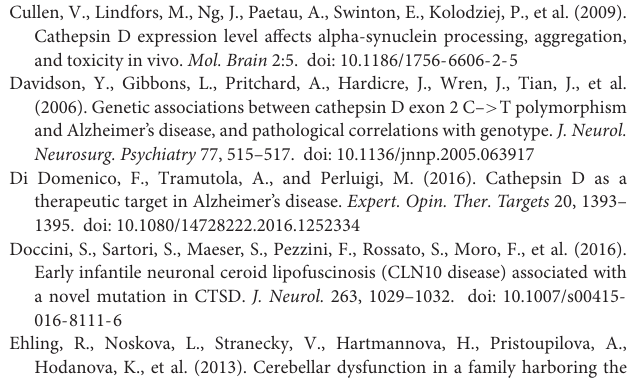
Supplementary Figure 4 | Cellular localization of PD-associated CTSD variants in SH-SY5Y CTSD KO cells. Representative confocal microscopy images of immunofluorescence stainings of PD-CTSD variants, overexpressed in SH-SY5Y cells deficient for CTSD (CTSD KO). Cells were stained for CTSD (green), the lysosomal marker LAMP2 (red), and DAPI as nuclear stain (blue). Yellow staining indicates lysosomal localization of CTSD variant. Scale bar: 20 µ m. Supplementary Figure 5 | Analyses of confocal images for CTSD localization, lysosomal vesicle number, and size as well as maturation of PD-associated CTSD variants. (A) Analysis of intracellular co-localization of PD-associated CTSD variants in SH-SY5Y cells deficient for CTSD (CTSD KO). The Pearson’s correlation coefficient was used to determine the co-localization of PD-CTSD mutants with lysosomal marker LAMP2 (total n = 11–15 in three independent experiments). (B) Quantification of LAMP2-positive vesicle number per cell ( n = 11–19, derived from cells from three independent experiments). (C) Analyses of average LAMP2-positive vesicle size per cell ( n = 12–19, derived from three independent experiments). (D,E) Analysis of protein maturation of PD-CTSD mutants: ratio of mature CTSD divided by immature CTSD level in SH-SY5Y CTSD KO cells (D) and H4 CTSD KO cells (E) both normalized to CTSD wt ( n = 4–8). All statistical analyses were performed by using a one-way ANOVA followed by a Tukey’s multiple comparison test. ∗∗ p < 0.01, ∗∗∗∗ p < 0.0001. Supplementary Figure 6 | a-Syn western blot and level after lysosomal inhibition. (A) Whole immunoblot of Figure 4A exhibiting no a-syn bands at higher molecular weight (a-syn antibody: Syn-1). (B) Representative immunoblot of SH-SY5Y CTSD KO cells transfected with CTSD wt co-expressing a-syn. Cells were treated with lysosomal inhibitor bafilomycin A1 (BafA1) or cathepsin D inhibitor pepstatin A (PepA), resulting in increased a-syn level (a-syn antibody: Syn-1). Analysis of a-syn signal after normalization to loading control indicating a significant increase of a-syn level after treatment of cells with BafA1 and PepA. Statistical analysis was performed using a one-way ANOVA followed by a multiple comparison test. Significances were tested against CTSD mock ( ∗ p < 0.05, ∗∗ p < 0.01). Supplementary Figure 7 | Molecular dynamics simulation (MDS) of the A239V variant of CTSD. (A) Original crystal structure of CTSD (PDB-ID: 4OBZ) bound to the 2S4 inhibitor. The light chain is displayed in blue, the heavy chain in gray. Active site residues are shown in spacefill red with 2S4 in orange (ball and stick). Alanine 239 is shown in cyan (ball and stick). (B) As a start conformation for MDS, the 2S4 inhibitor was removed to allow conversion of the structure into an unbound state. The single amino acid exchange was introduced using UCSF Chimera (swapaa). Coloring as in (A) . (C) Superimposed image of the start conformation (coloring as in A ) and the three end conformations post-MDS (green) for CTSD wt. (D) Superimposed image of the start conformation (coloring as in A ) and the three end conformations post-MDS (orange) for A239V-CTSD. (E) Superimposed image of the three end-conformations post-MDS for CTSD wt (green) and CTSD A239V (orange). The insert shows the loop carrying the A239V variant (filled black arrow) and the loop formed by amino acids 75–77 located within the light chain (empty black arrow). (F) As in (E) , but with the structures turned by 90 ◦ around the y